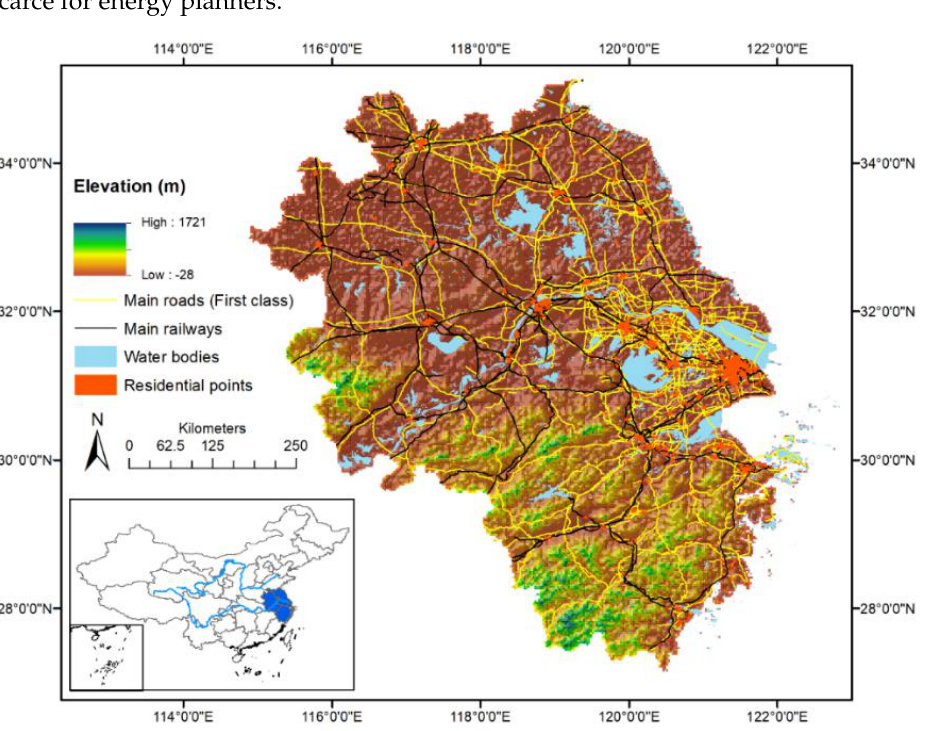
Figure 1. Study area — the Yangtze River Delta region.